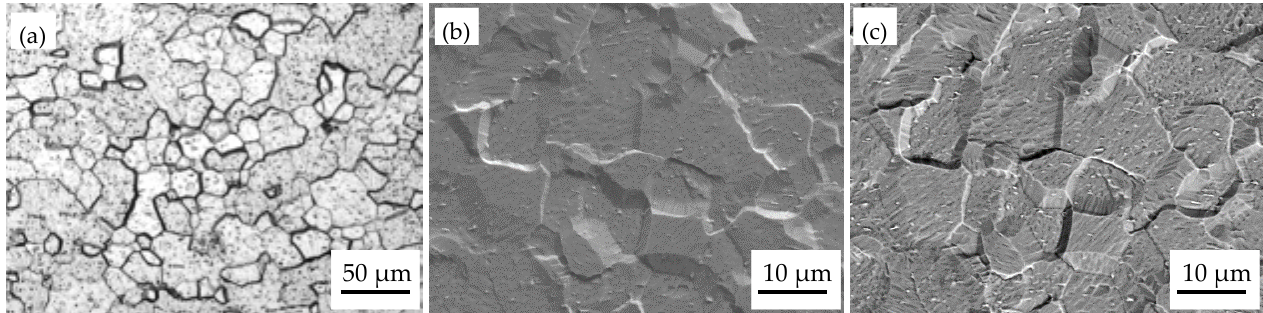
Figure 1. Microstructures of annealed Gr.4 strip: ( a ) OM, ( b ) SE, and ( c ) BSE.